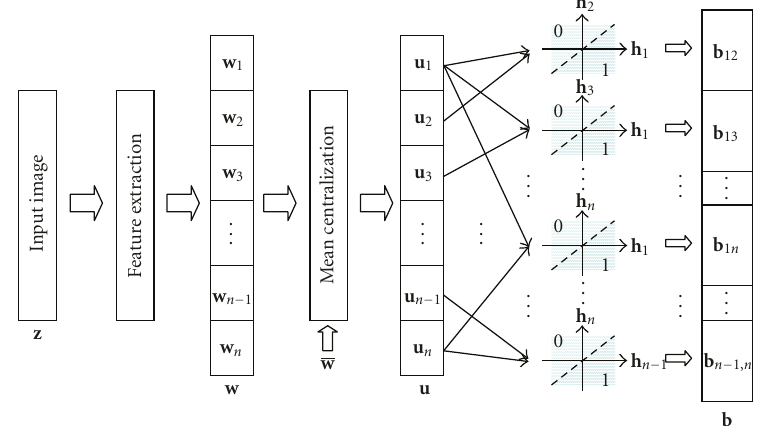
Figure 2: Diagram of Pairwise Relational Discretization (PRD) method.